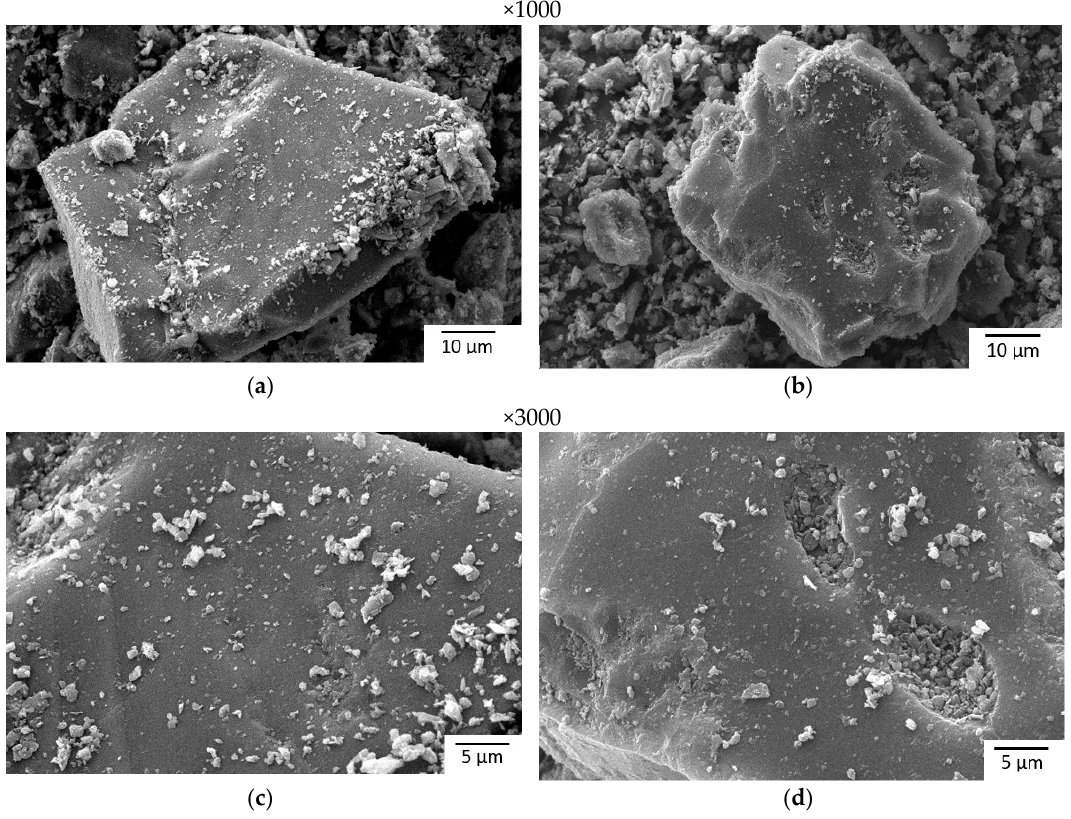
Figure 1. SEM images of the initial anthracite and semi ‐ coke samples: ( a , c )—sample A; ( b , d )—sample SC. Figure 1. SEMimagesoftheinitialanthraciteandsemi-cokesamples: ( a , c )—sampleA;( b , d